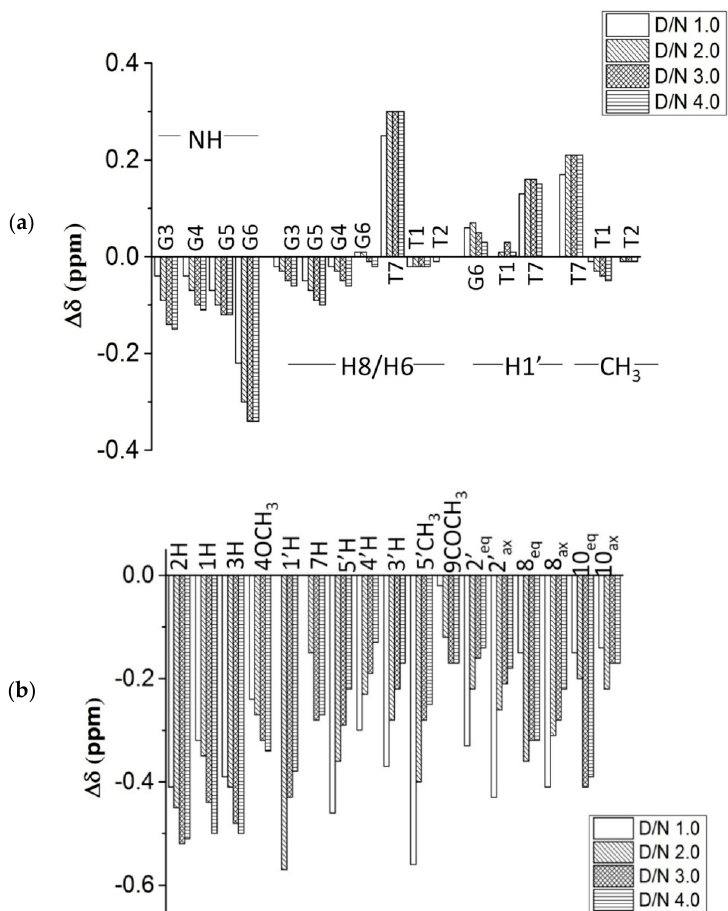
Figure 4. Bar diagram showing change in 1 H chemical shift ( Δδ ) of ( a ) [d-(TTGGGGT)] 4 protons and ( b ) daunomycin protons on complexation at D/N = 1.0, 2.0, 3.0 and 4.0 in 10 mM phosphate buffer with 100 mM of KCl (90% H 2 O + 10% D 2 O) at 25 °C. Table 2. 1 H Chemical shift (ppm) of daunomycin protons in free daunomycin ( δ f ) and daunomycin-[d-(TTGGGGT)] 4 complex ( δ b ) at D/N = 4.0 in KBPES buffer containing 100 mM of KCl (90% H 2 O + 10% D 2 O solvent) at 25 °C. Change in chemical shift of daunomycin protons due to binding, Δδ = δ b − δ f . − ve Δδ indicates upfield shift.